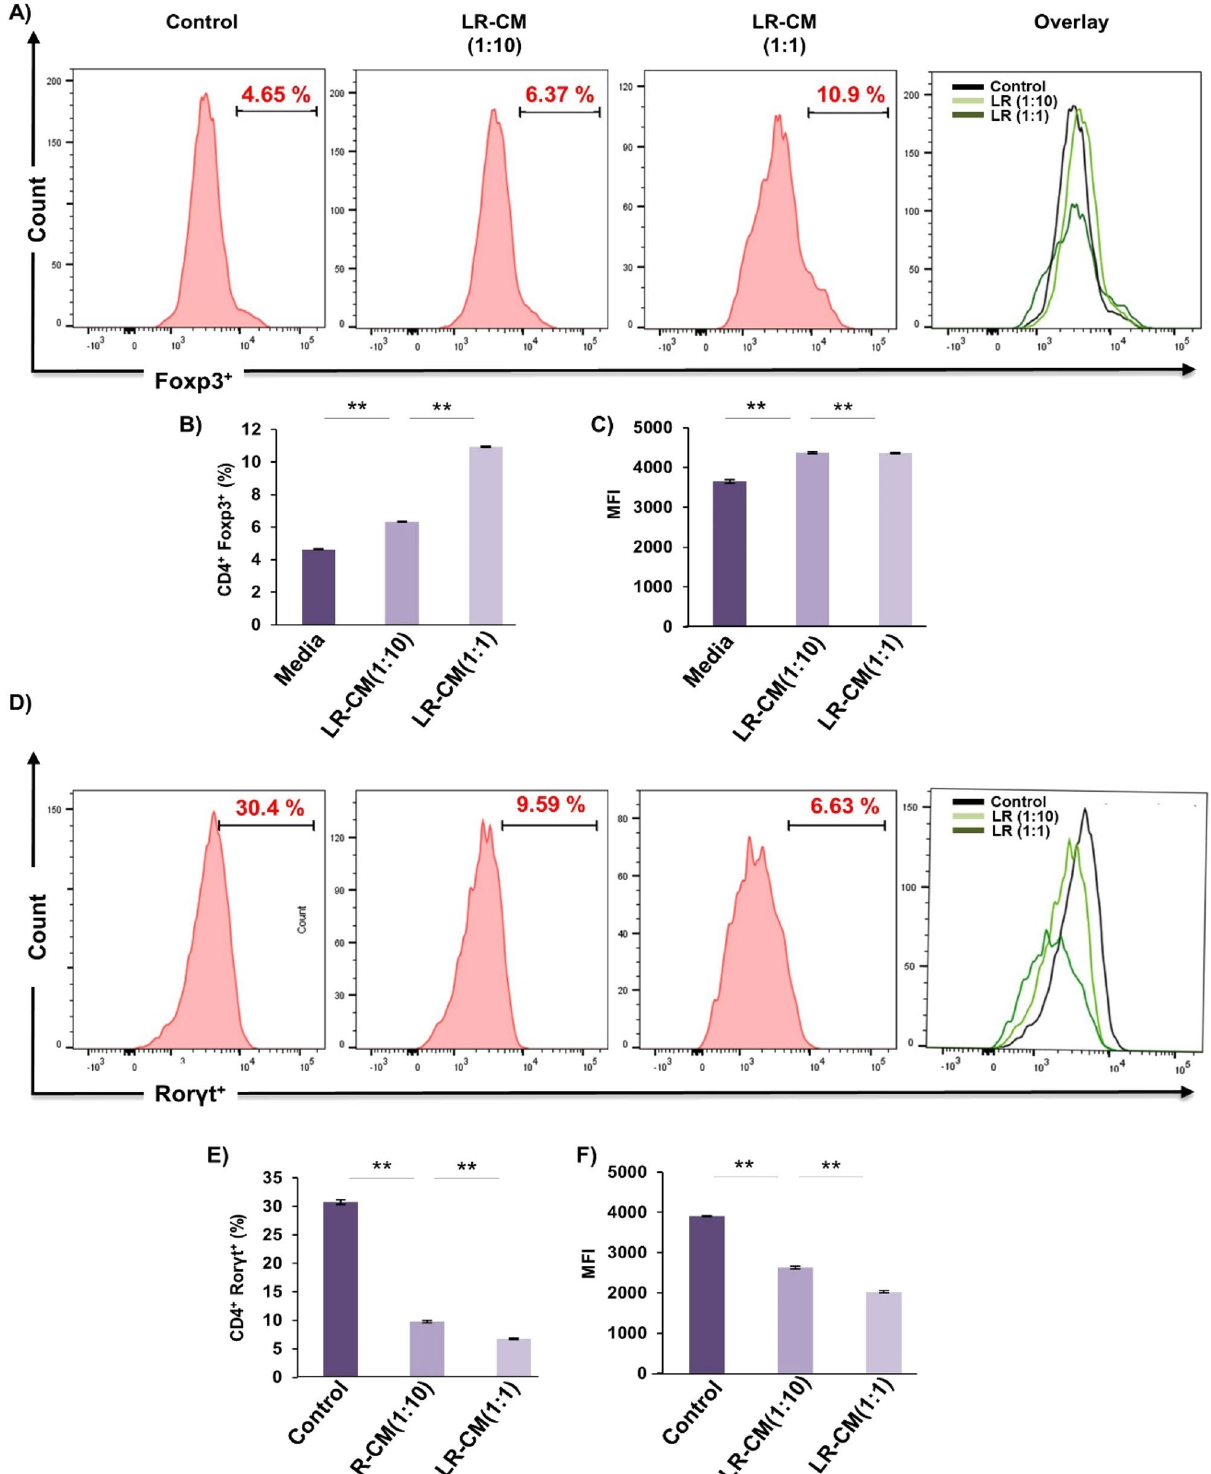
Figure 9. LR modulates Treg and Th17 cell differentiation in vitro. ( A ) For Tregs differentiation, splenic naïve CD4 + T cells stimulated with anti-CD3 and anti-CD28 mAbs were incubated with TGF-β1 and IL-2 with or without LR-CM. After 4 days, cells were analysed for Foxp3 expression by FACS. ( B ) Average percentage of CD4 + Foxp3 + cells from two independent experiments of A. ( C ) MFI showing the expression of Foxp3 in CD4 + T cells. ( D ) For Th17 differentiation, splenic naïve CD4 + T cells stimulated with anti-CD3 and anti-CD28 mAbs, incubated with TGF-β1, IL-6, IL-23 with or without LR-CM. ( E ) Average percentage of CD4 + Roryt + cells from three independent experiments of D. ( F ) MFI showing the expression of Roryt in CD4 + T cells. Data is reported as Mean ± SEM. Similar results were obtained in two independent experiments. MFI, mean fluorescence intensity. Statistical significance of each parameter was assessed by ANOVA followed by paired group comparison. * p < 0.05, ** p < 0.01, *** p < 0.001, **** p < 0.0001 compared with indicated